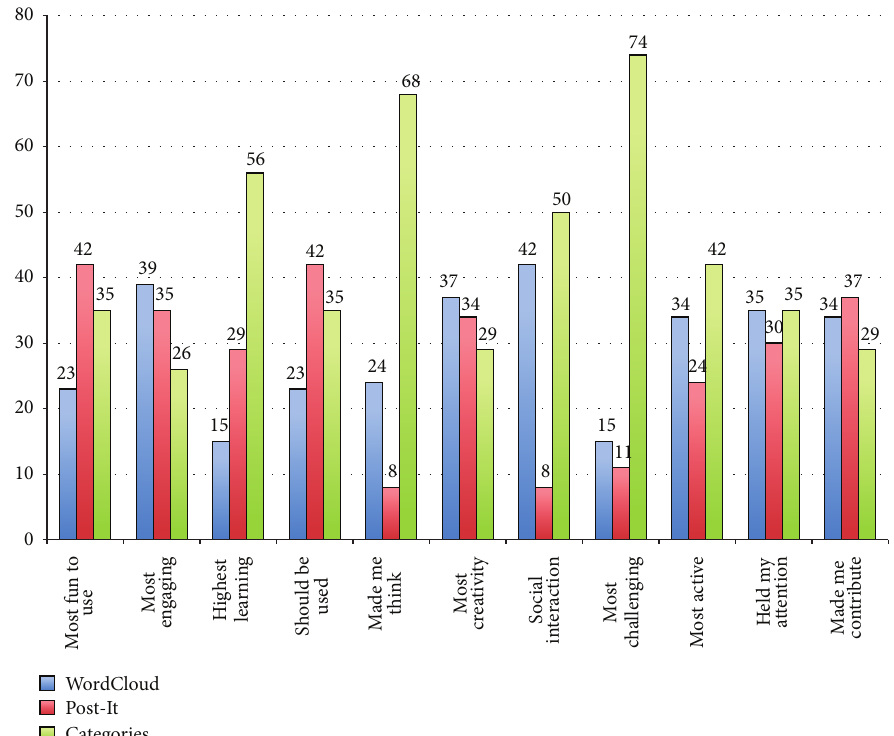
Figure 4: Results of the evaluation of use of applications from lecture one.